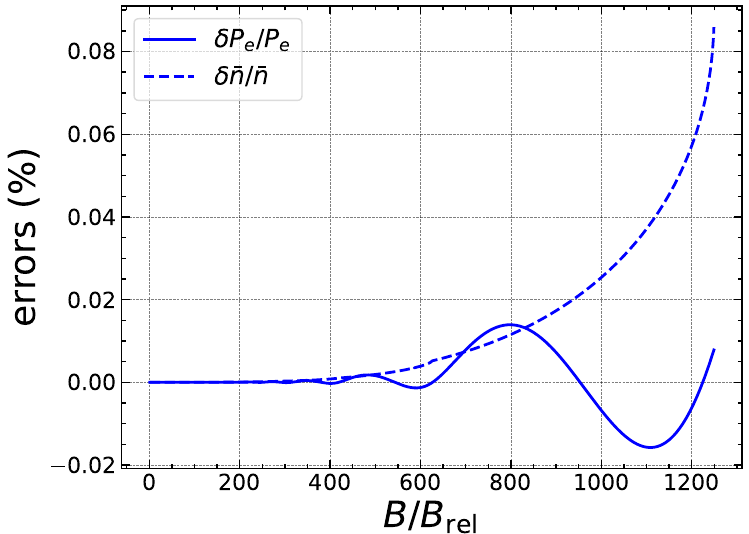
Figure 2. Same as Figure 1 for γ e = 50. All electrons are confined to the lowest Landau–Rabi level at B (cid:63) = ( γ 2 e − 1 ) /2 =